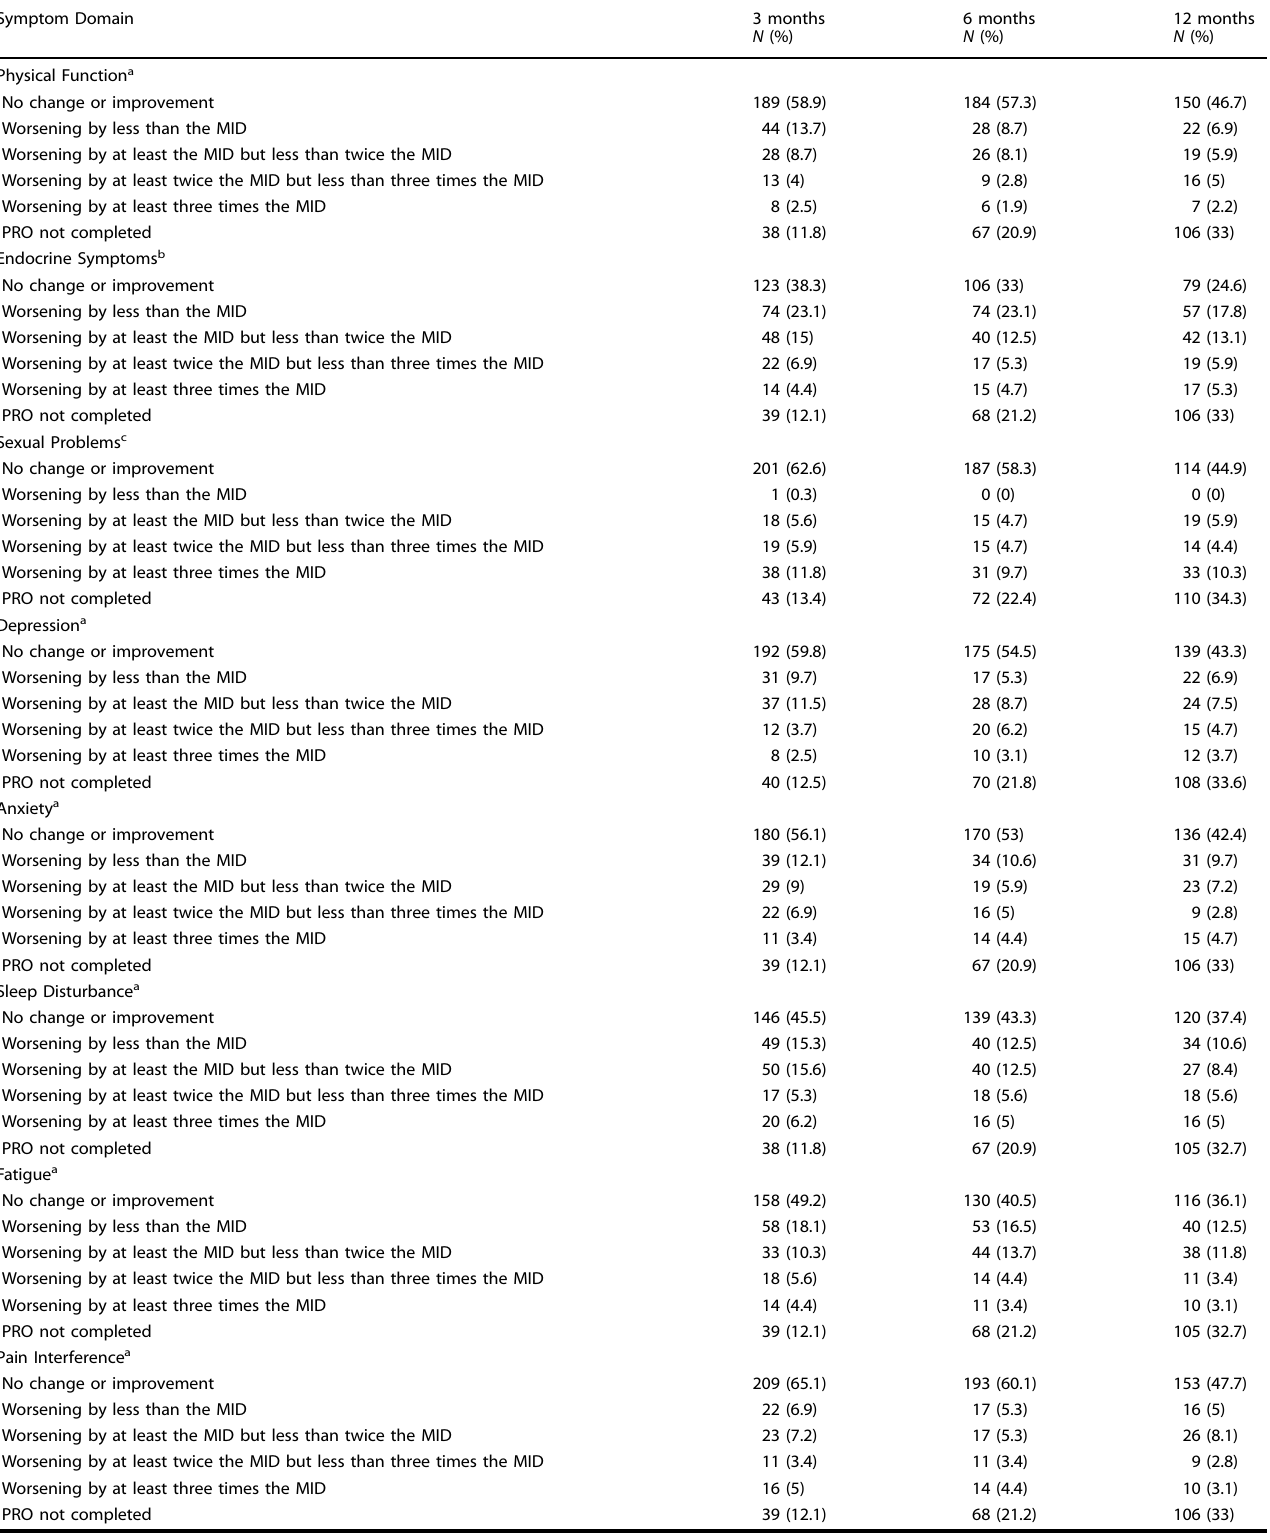
Table 3. Change in symptoms compared to baseline at each time point through 12